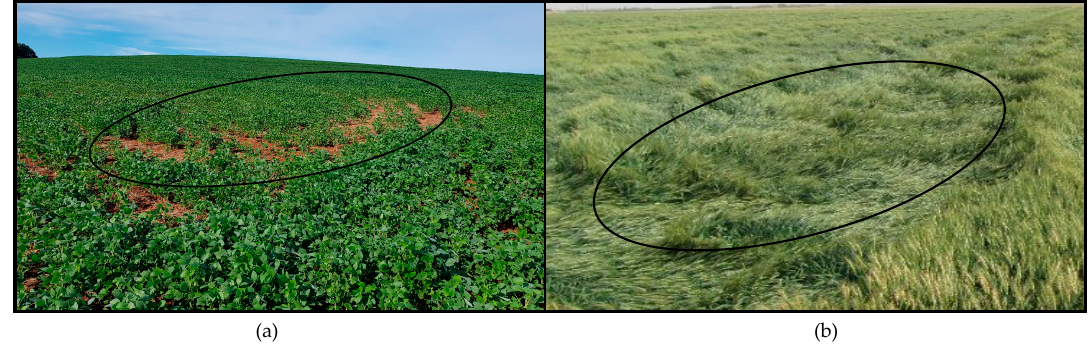
Figure 1. Problems caused by irregularity in the fertilizer distribution. ( a ) Fertilizer underdosing; ( b ) fertilizer overdosing.